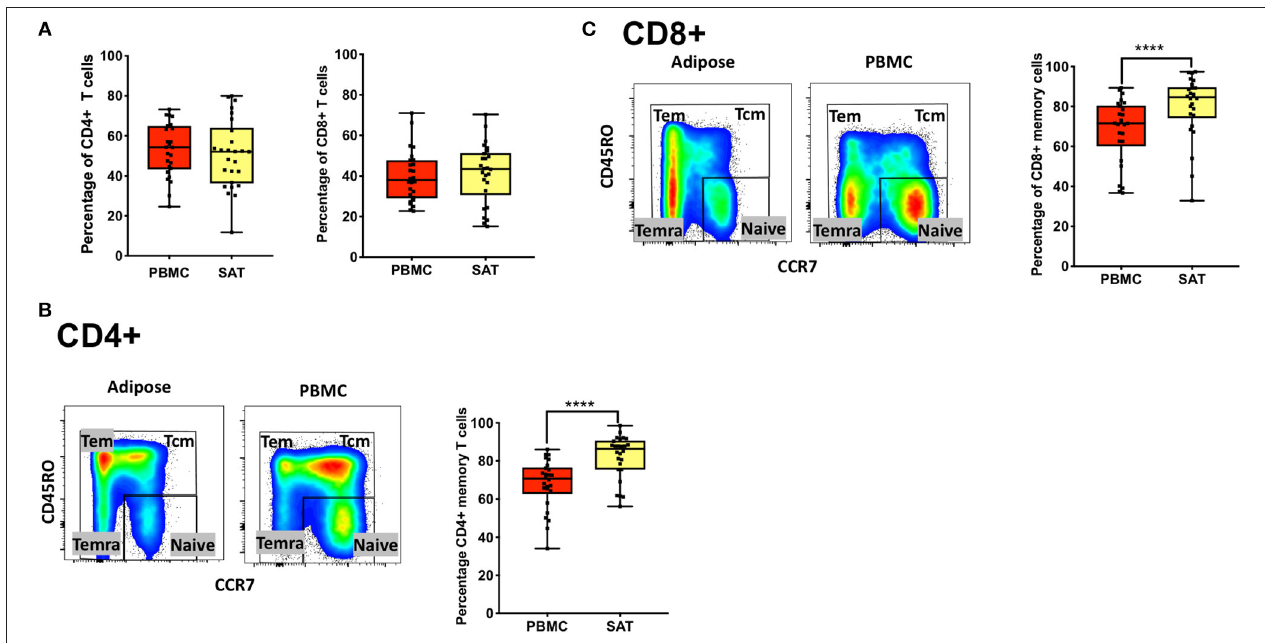
FIGURE 1 | Subcutaneous adipose tissue from PLWH has a higher percentage of CD4 + and CD8 + memory T cells compared to matched blood samples. (A) Frequencies of total CD4 + and CD8 + T cells (percentage of CD3 + cells) in subcutaneous adipose tissue (SAT) and blood (PBMC) from all 26 PLWH. (B) Representative plot showing gating of CD4 + memory T cells (gated on CD3 + ) in SAT and PBMC depicted by the yellow and red shading, respectively; on the right are individual values and means. (C) Representative plot showing total CD8 + memory T cells in adipose tissue and PBMC. The box and whiskers plot indicate mean ± SD. Wilcoxon matched pair signed test was used to calculate statistics (A-C); **** p <